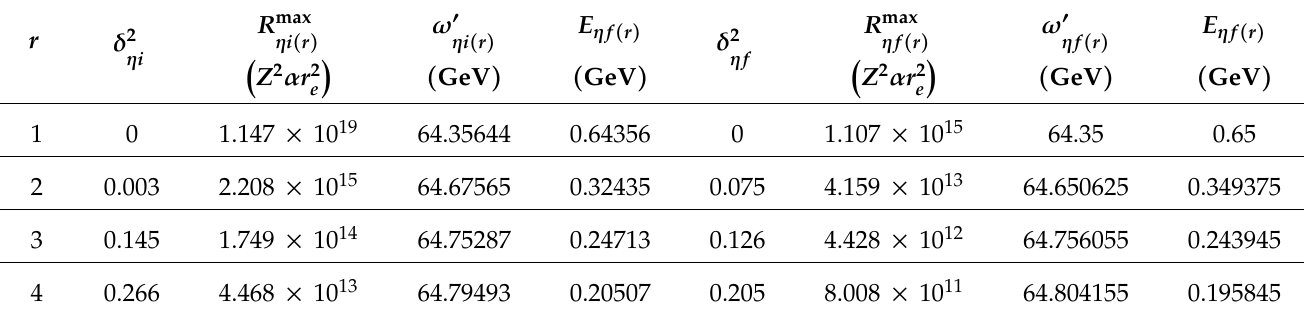
Table 1. The values of the resonant frequency and the square of the outgoing angle of the spontaneous gamma quantum for the maximum value of the maximum resonant di ff erential cross-section (see Figure 2). The frequency and intensity of the electromagnetic wave are ω = 0.2 keV and